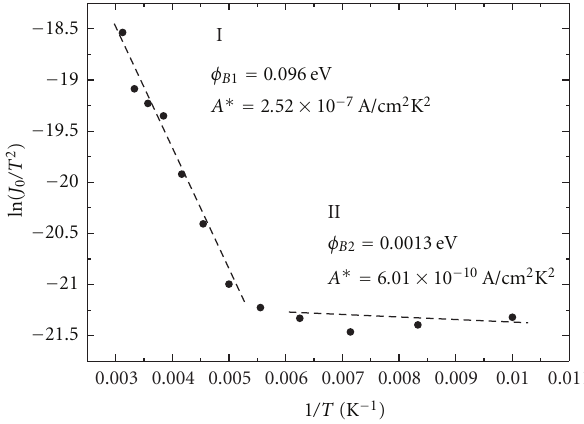
Figure 4: Richardson plots of the ln( J 0 /T 2 ) versus 1/ T for the Al/HfO 2 /p-Si (MOS)